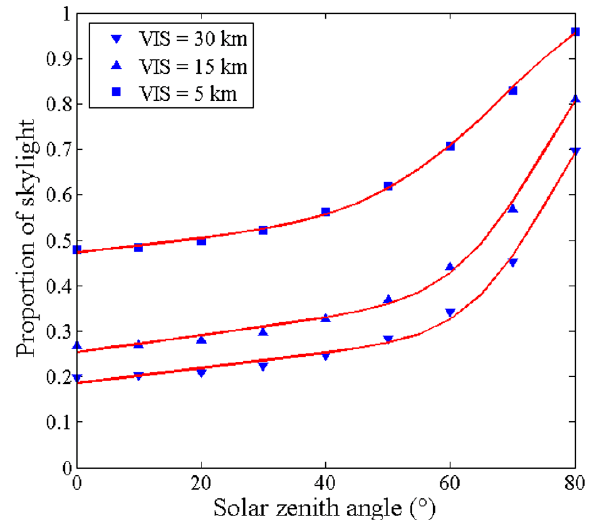
Figure 3. Modeling skylight proportions from solar zenith angle (SZA) and visibility (VIS) modeled from the second simulation of a satellite signal in the solar spectrum (6S) (blue signals represent 6S model outputs, whereas red lines represent the fitted equations).